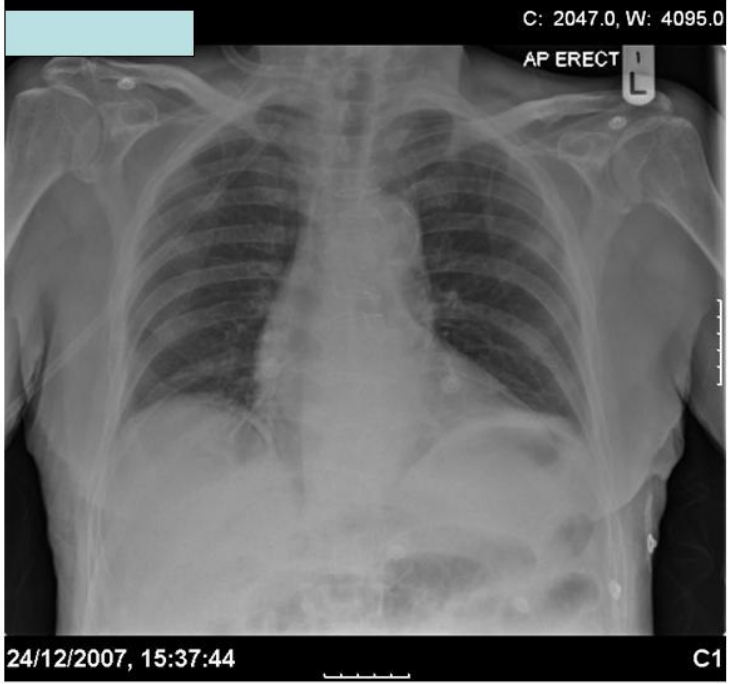
FIGURE 3. Chest X-ray showing air under the right